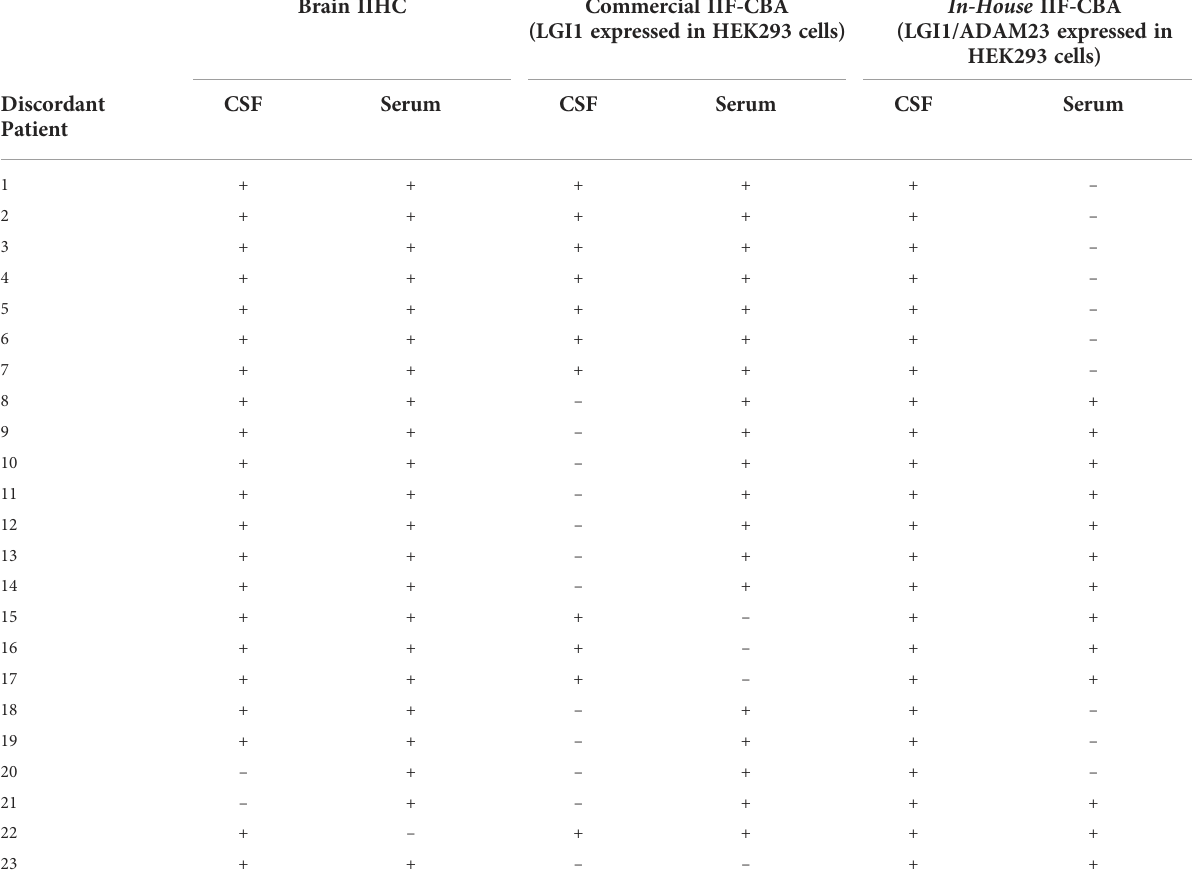
TABLE 1 Findings in serum and CSF of patients with anti-LGI1 encephalitis and discordant results in the indicated tests.